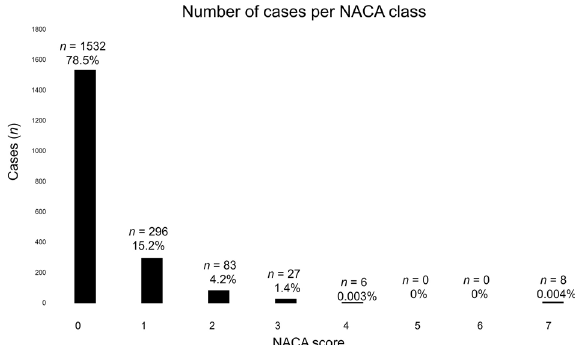
Figure 1. Most victims were uninjured, and only eight fatal cases could be identified. This is further evidenced by the average NACA score for the total sample of 0.32 ± 0.71.